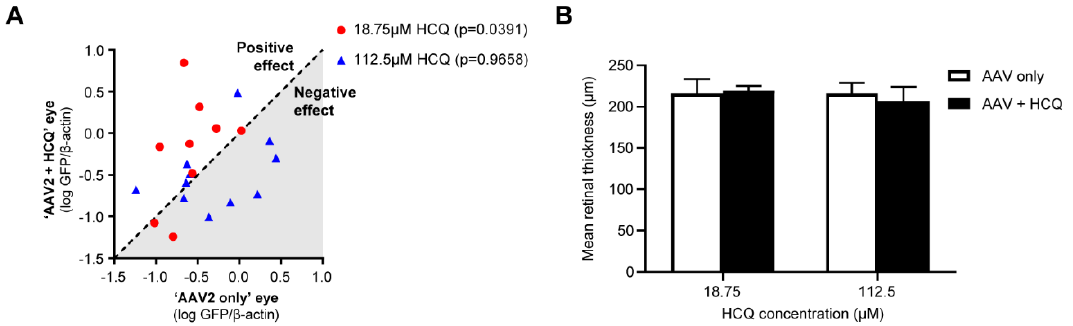
Figure 3. Dose effect of HCQ on improving the efficacy of adeno-associated viral (AAV)-mediated retinal gene therapy in vivo. C57BL / 6J mice were subretinally injected with 1 × 10 8 vector genomes of AAV8(Y733F) GRK1.GFP with and without either 18.75 µ M ( n = 10) or 112.5 µ M ( n = 11) HCQ. ( A ) The protein quantification of GFP expression normalised to β -actin (expressed as log 10 ) 6 weeks post-injection of AAV only injected eyes ( x -axis) plotted against AAV with HCQ injected eyes ( y -axis). Each point represents an individual animal. Points above the line represent a positive effect and below a negative. The p-value for analysis between paired eyes is given in the legend using a Wilcoxon matched-pairs signed rank test. ( B ) Mean total retinal thickness measured by in vivo spectral domain optical coherence tomography imaging (± SEM).